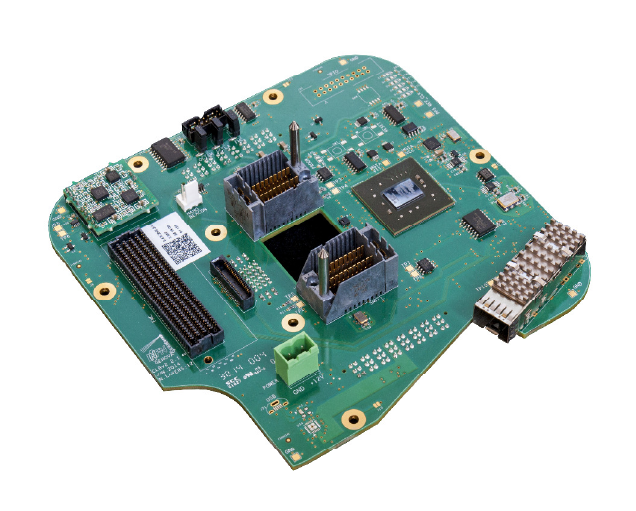
Figure 2. The Central Logic Board of the KM3NeT neutrino